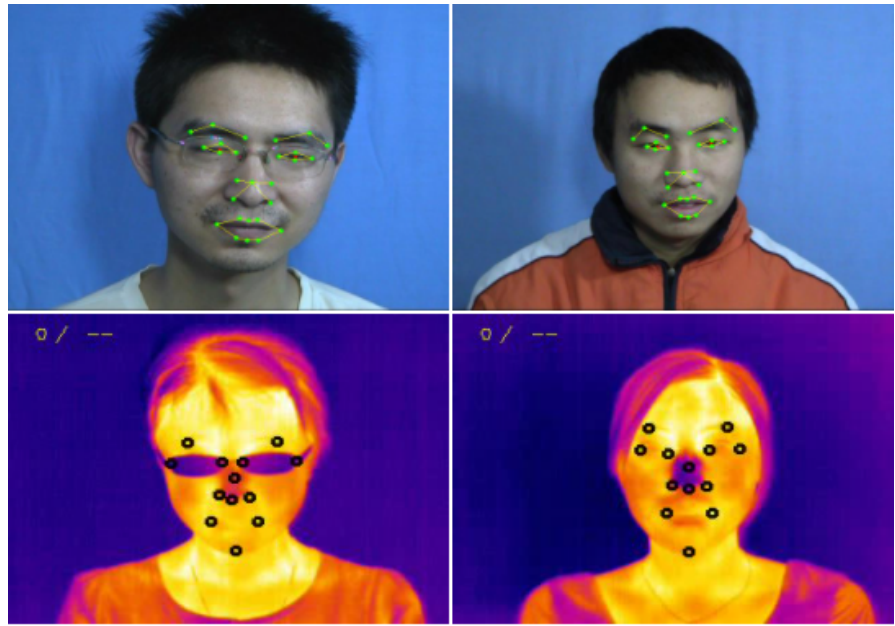
Figure 2. VIS and NIR face images with and without glasses